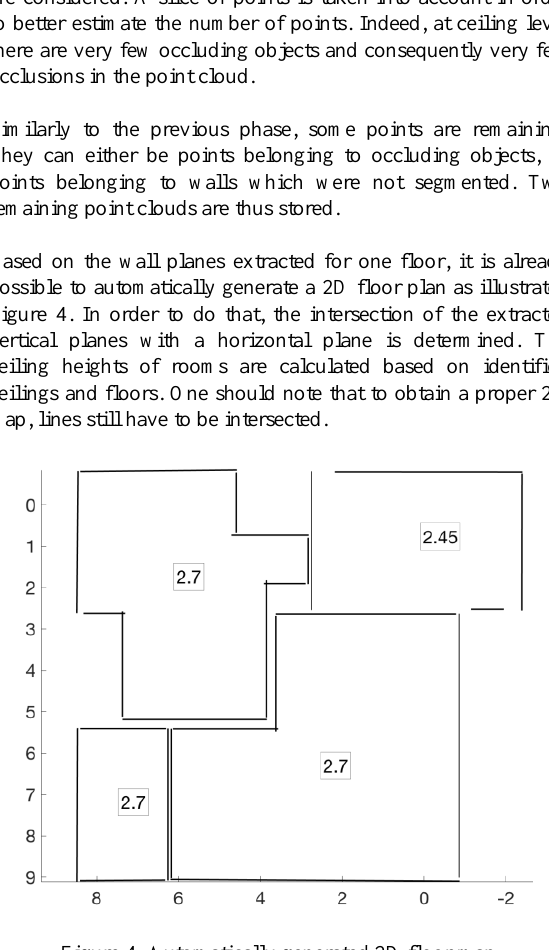
Figure 4. Automatically generated 2D floor